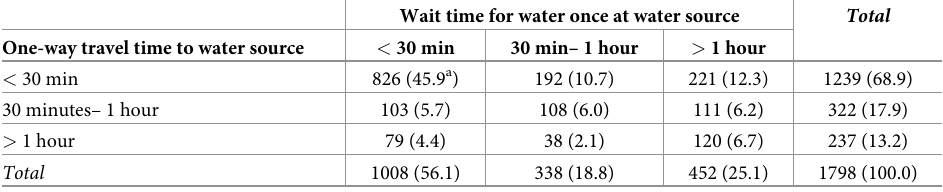
Table 2. One-way travel time to water and wait time for water once at the water source.